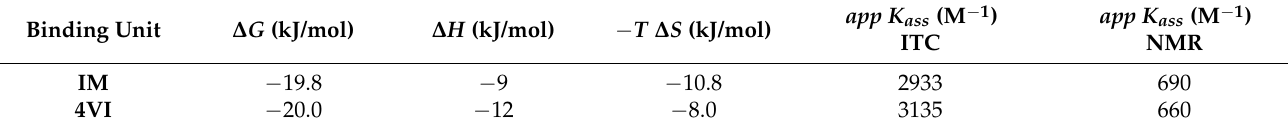
Table 3. Thermodynamic profiles: apparent association constants ( app K ass ) by ITC and NMR, changes in Gibbs free energy ( ∆ G) , changes in enthalpy ( ∆ H) , and changes in entropy ( − T ∆ S) for the interaction of paraxanthine (PX) with imidazole (IM) and 4-vinylimidazole